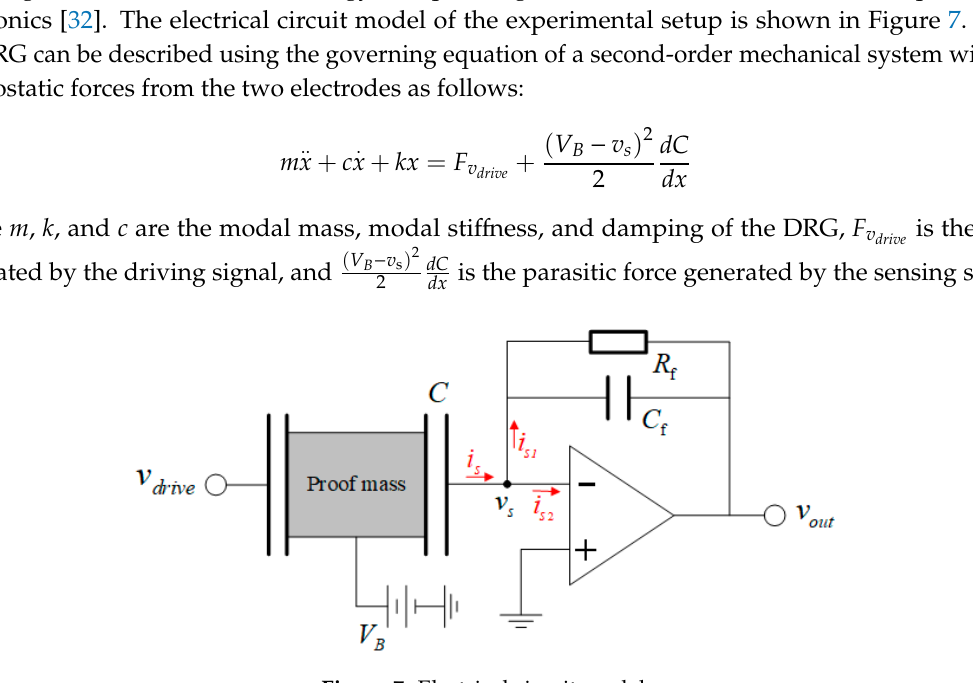
Figure 7. Electrical circuit model.